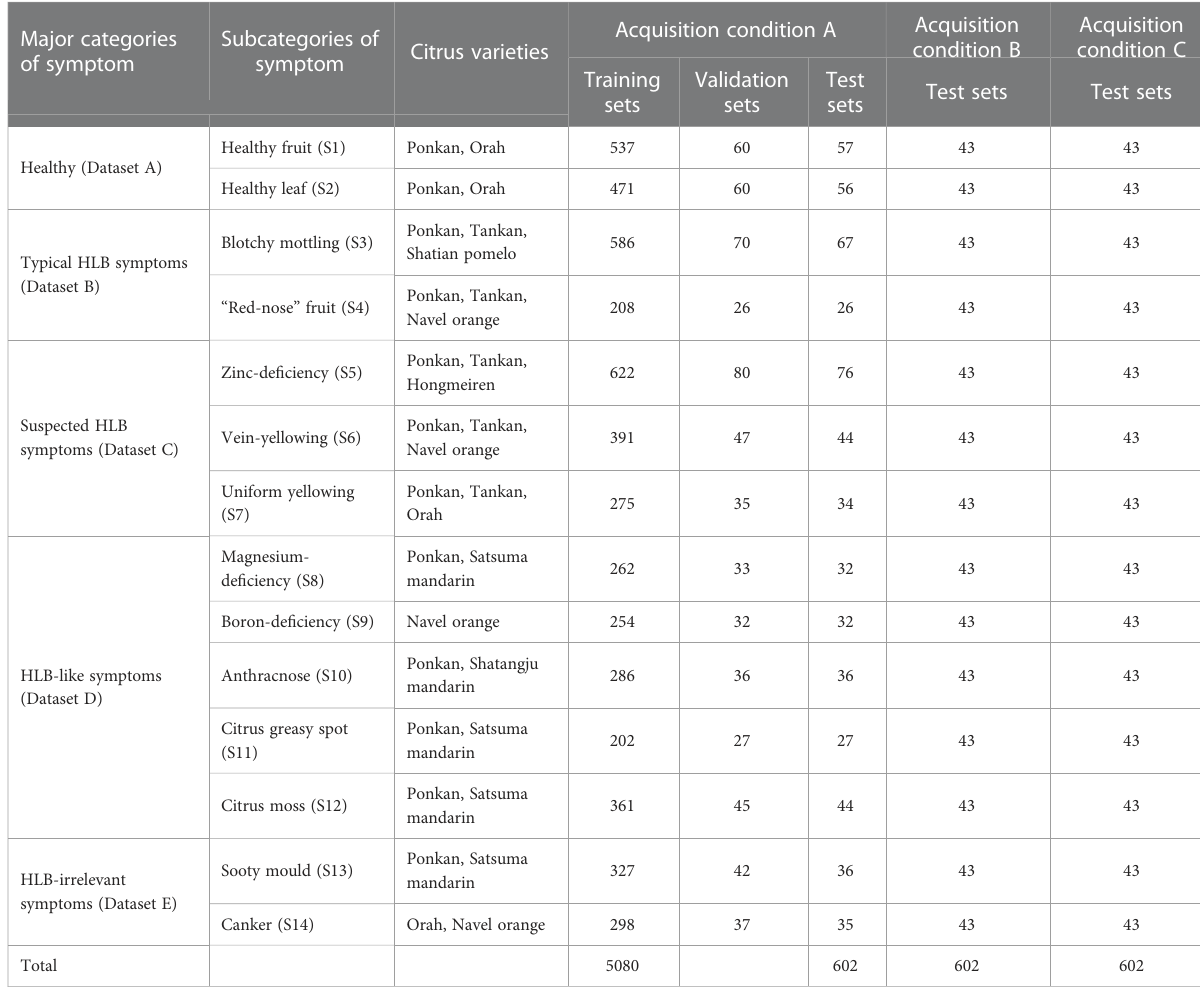
TABLE 1 Symptom categories, varieties, and sample sizes of citrus image database acquired under different conditions.